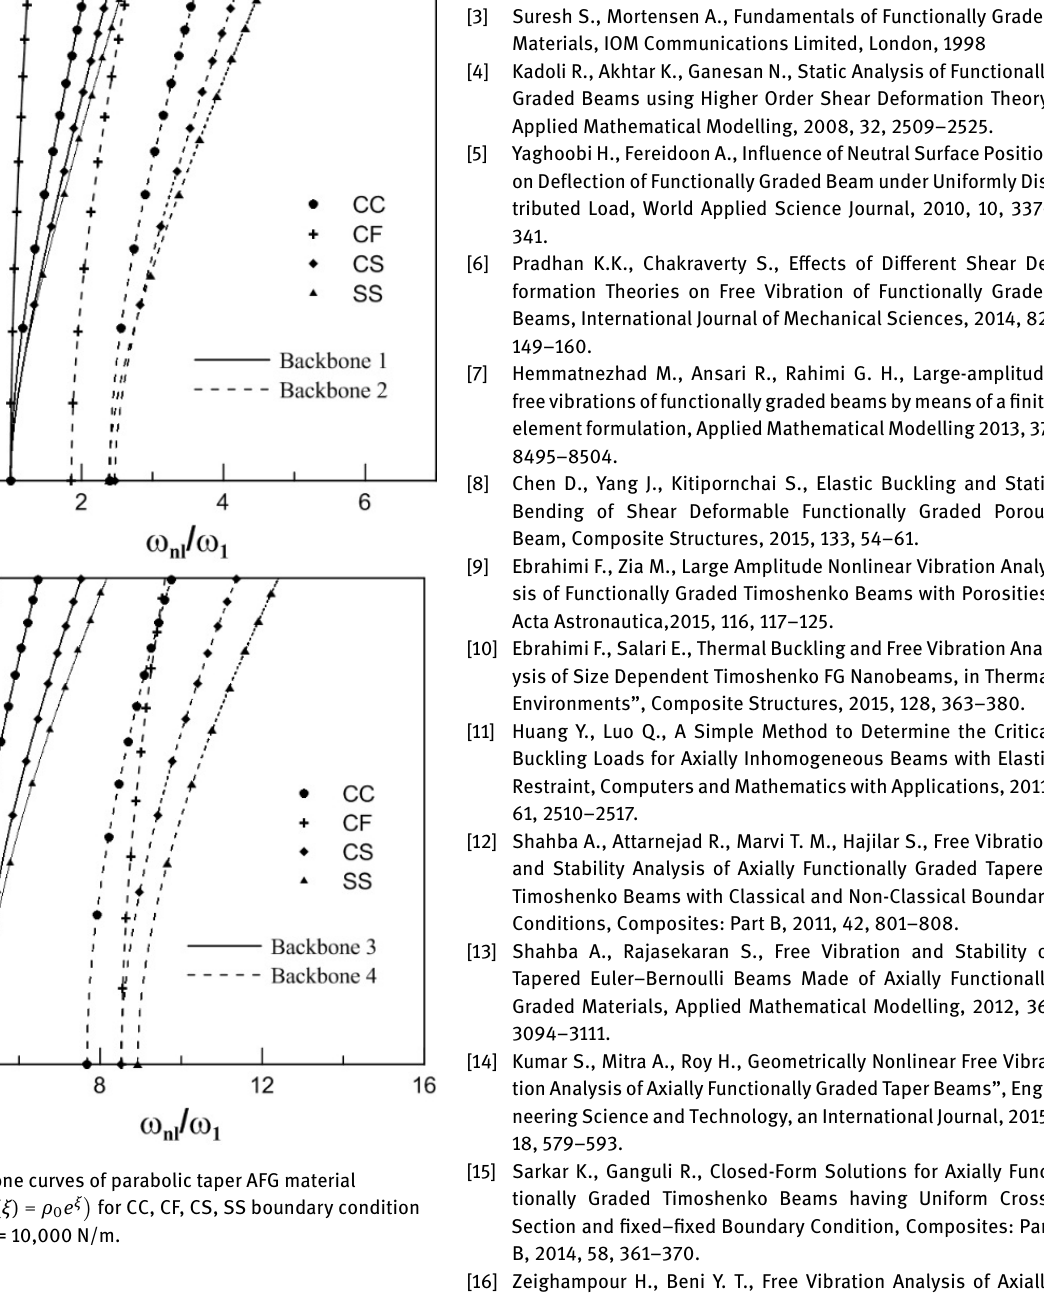
stiffness. For all combinations of the system parameters hardening type of nonlinearity is